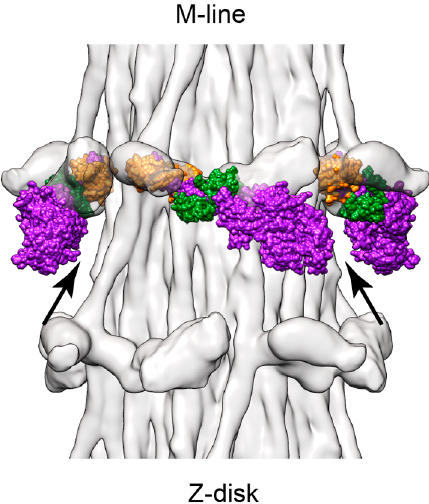
Figure 5. Fitting of a post rigor myosin head conformation into the relaxed Lethocerus thick filament. The atomic model of Doryteuthis pealeii (squid), PDB 3i5f, a post-rigor conformation [82] fit using only the RLC portion of the lever arm onto the free head of atomic model of [6]. Arrows point to the space between the free head and the myosin rods in the backbone; there are no clashes between the MD and the backbone. The related rigor-like structure, PDB 3i5g, fits equally well. The degree of clash observed with other post rigor crystal structures having complete lever arms, e.g., 2mys and 1dlf, fit using the same criterion is variable. Coloring scheme has the RLC (orange), ELC (green) and heavy chain (purple). Note that the blocked head density and atomic model have been removed for clarity.